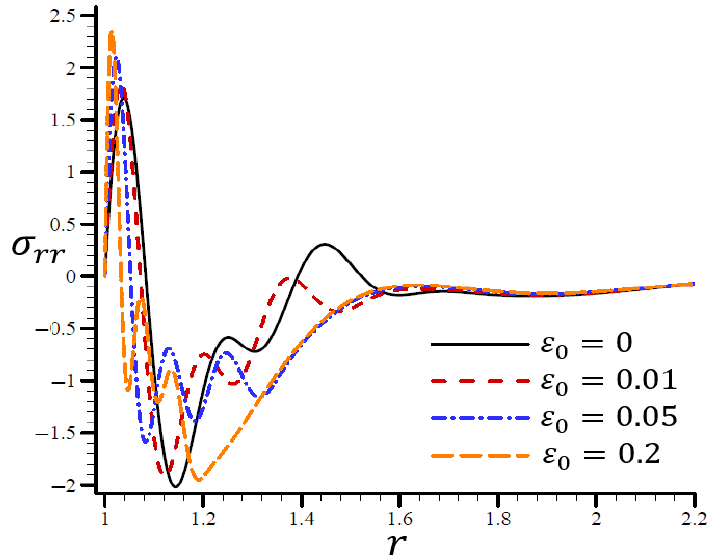
Figure 20. The influence of ε 0 on radial stress σ rr through the radial direction of the spherical hole using the RTPL model.